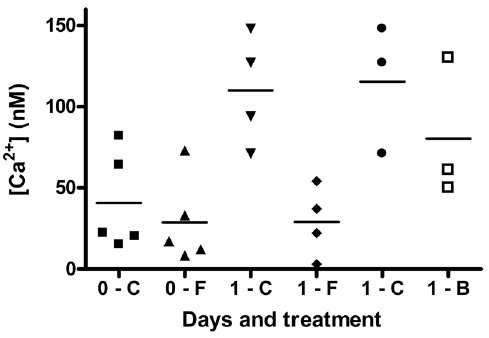
Figure 4. Effects of FBP and BDM on intracellular calcium. Aliquots of myocytes were given no additions, 5 mM FBP, or 5 mM BDM, and analyzed for intracellular Ca2 + either immediately or after 24 hours of incubation at 3 u C. Individual results are plotted, with means of the groups indicated by horizontal lines. The first two sets of data are for five experiments with fresh myocytes without ( & ) or with ( m ) FBP. The second two sets of data are for four experiments with myocytes incubated for one day without ( . ) or with ( ¤ ) FBP. The last two sets of N data are for three experiments with myocytes incubated for one day ) or with ( % ) BDM. without (